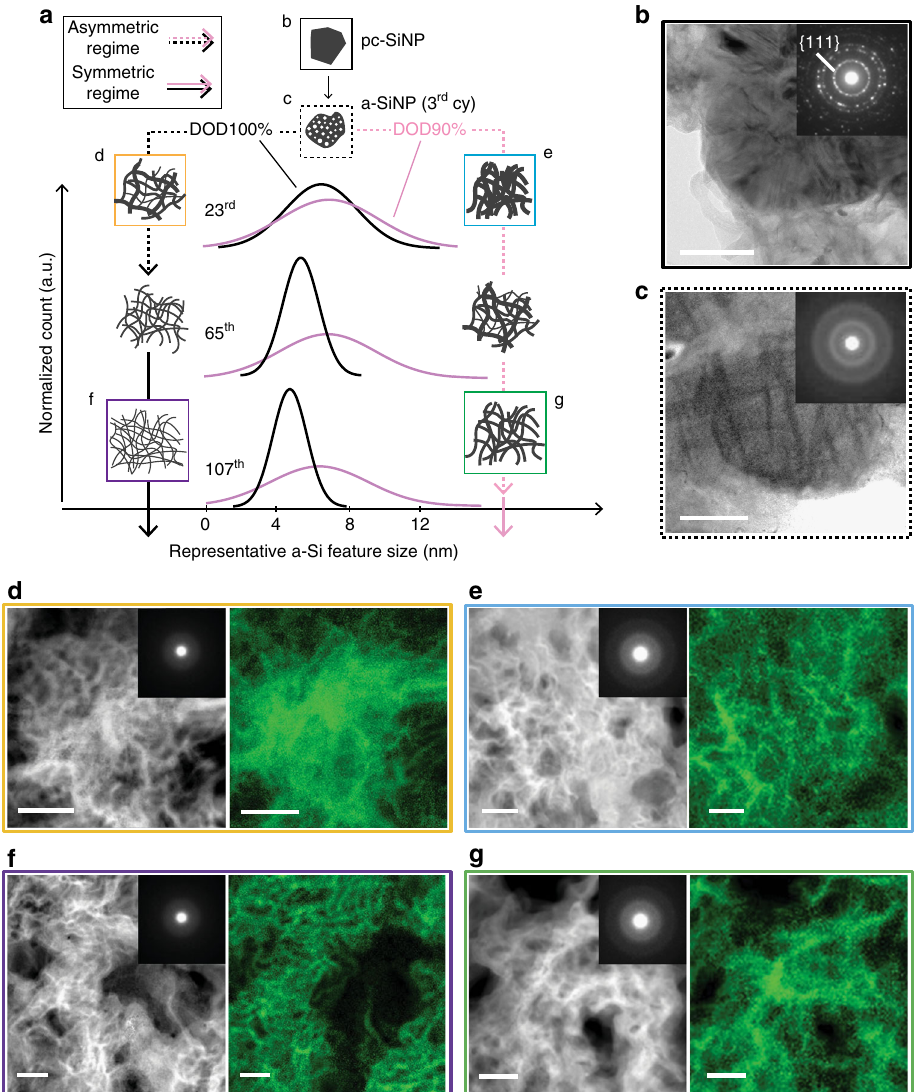
Fig. 5 Size distribution and electron microscopy images of fully delithiated Si. a Schematics of Si morphological changes over 107 cycles, combined with the Gaussian- fi tted size distribution curves of delithiated amorphous-Si (a-Si) for type-A electrodes cycled under depth of discharge (DOD)100% (left) and 90% (right). The distribution curves are stacked with a constant pitch to show the changes over cycles more clearly. Dotted and solid lines show the electrochemical asymmetric and symmetric regimes (Fig. 3h), respectively. The schematics surrounded by different colored squares correspond to the following electron microscopy images. Bright- fi eld TEM images for ( b ) as-is polycrystalline silicon nanoparticles (pc-SiNP) and ( c ) porous amorphous SiNP (a-SiNP) after the 2nd cycle. Inset shows the selected area diffraction pattern (SADP) of the imaged area. d – g High-angle annular dark fi eld (HAADF) with SADP inset (left) and electron energy loss spectroscopy (EELS) mapping (right) of delithiated a-Si at ( d , e ) the 23rd and ( f , g ) the 107 th cycle for ( d , f ) DOD100% and ( e , g ) DOD90%, respectively. All scale bars are 50 nm. Combining the results from HAADF and EELS, the feature size distribution for DOD100% becomes much narrower compared to that for DOD90% after the 65 th cycle. The trend of particle size and distribution is also shown